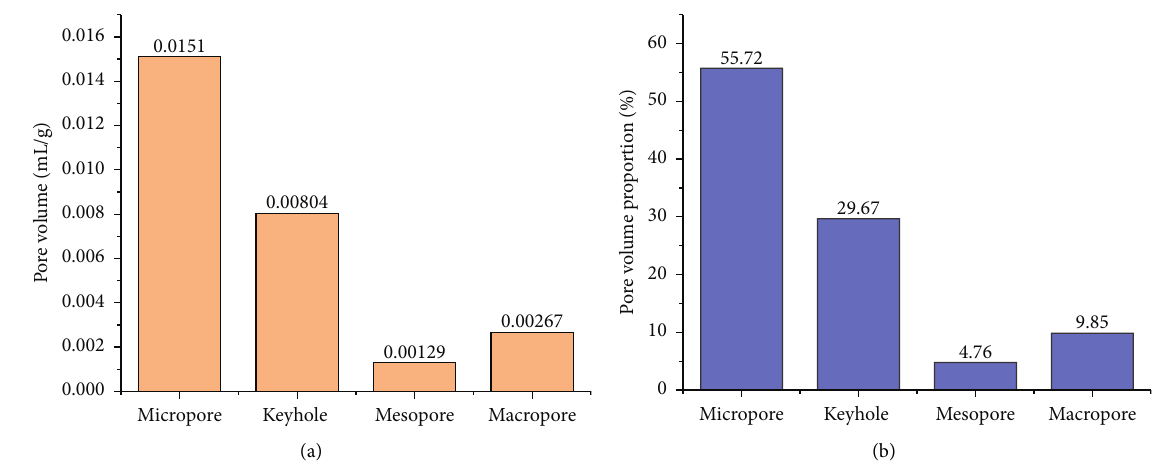
Figure 15: Pore volume distribution and proportion of no. 8 coal seam in Luling mine. (a) Pore volume. (b) Pore volume proportion.